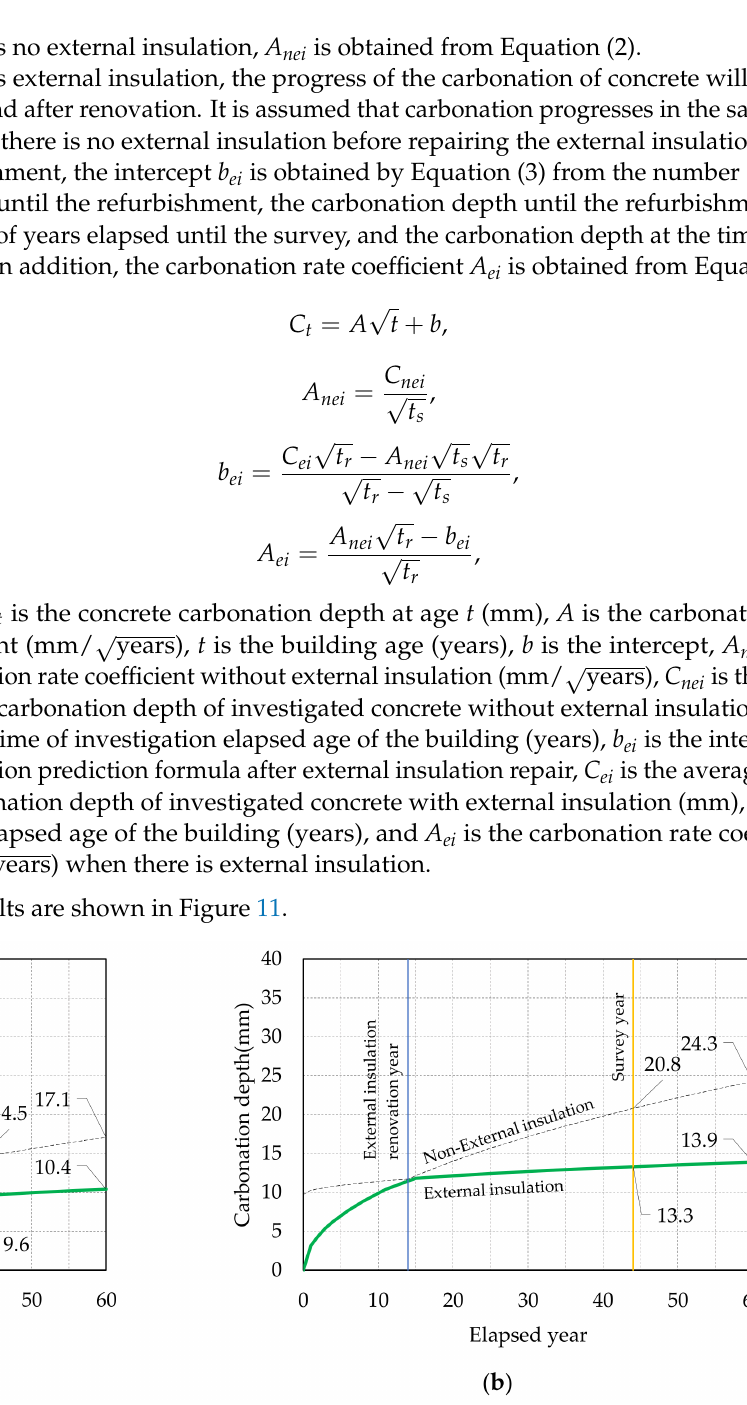
Figure 11. Comparison of carbonation suppression effect by external insulation. ( a ) Bldg. A., applied by combing adhesive, northeast wall, ( b ) Bldg. D., applied by ball-shaped adhesives, northwest